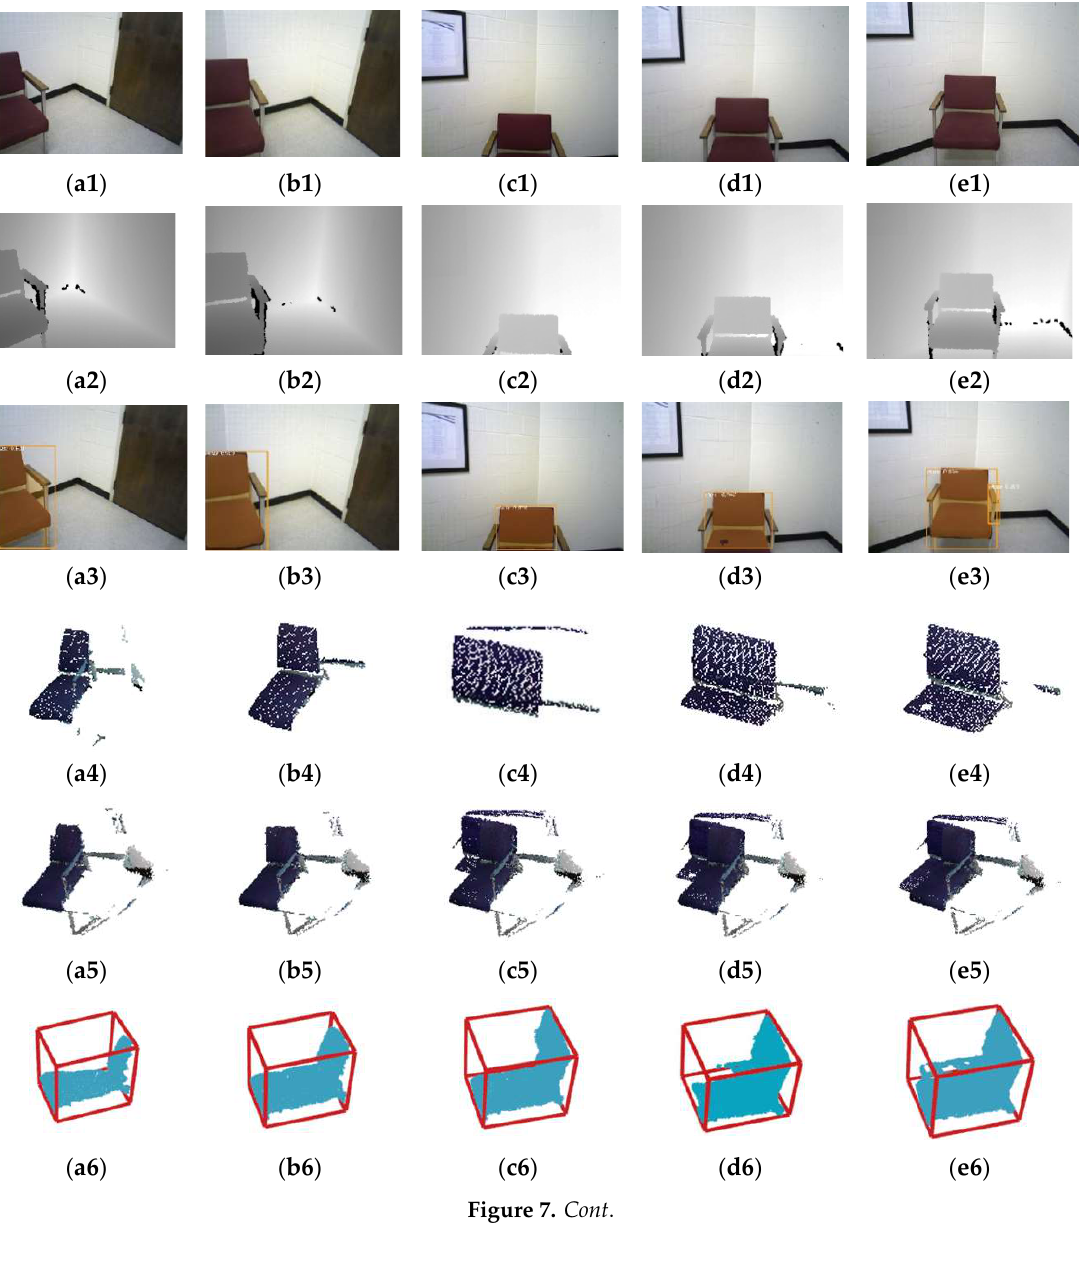
Figure 7. One example of 3D object detection on the SceneNN dataset(sequence ID: 011, ( a1 – e1 ) are the input RGB images as keyframes, ( a2 – e2 ) are depth images, ( a3 – e3 ) are the object instance object point cloud using multi-keyframe, ( a6 – e6 ) are the segmented object point cloud based on LCCP and 3D bounding box based on Manhattan frame estimation, and ( a7 – e7 ) are the final 3D object detection in the point cloud map). The chair can be merged more completely and the 3D bounding box is estimated more accurate after multi-keyframe fusion. Additionally, one example of object fusion progress is given to show the details, as shown in Figure 7. Multiple views of the object “chair” from the 011 sequence of the SceneNN dataset are detected and fused gradually. The shown progression includes RGB and depth images, detected mask images, extracted object point clouds, fused object point clouds, segmented object point